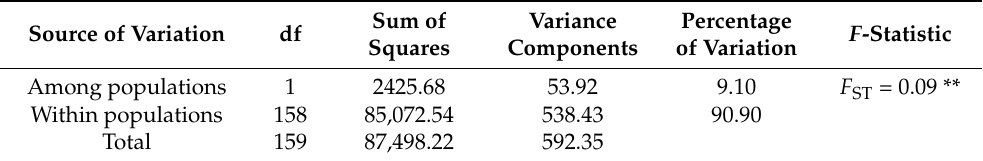
Table 4. Analysis of molecular variance (AMOVA) of R. mucronata population. Source of Variation